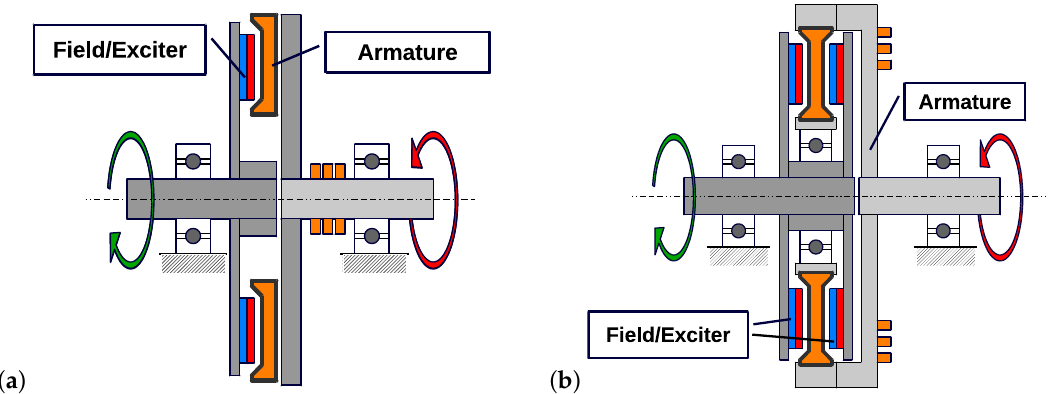
Figure 3. Dual rotor axial flux machine solutions: ( a ) single permanent magnet (PM) exciter disk and single armature disk; ( b ) two PM exciter disks and single armature